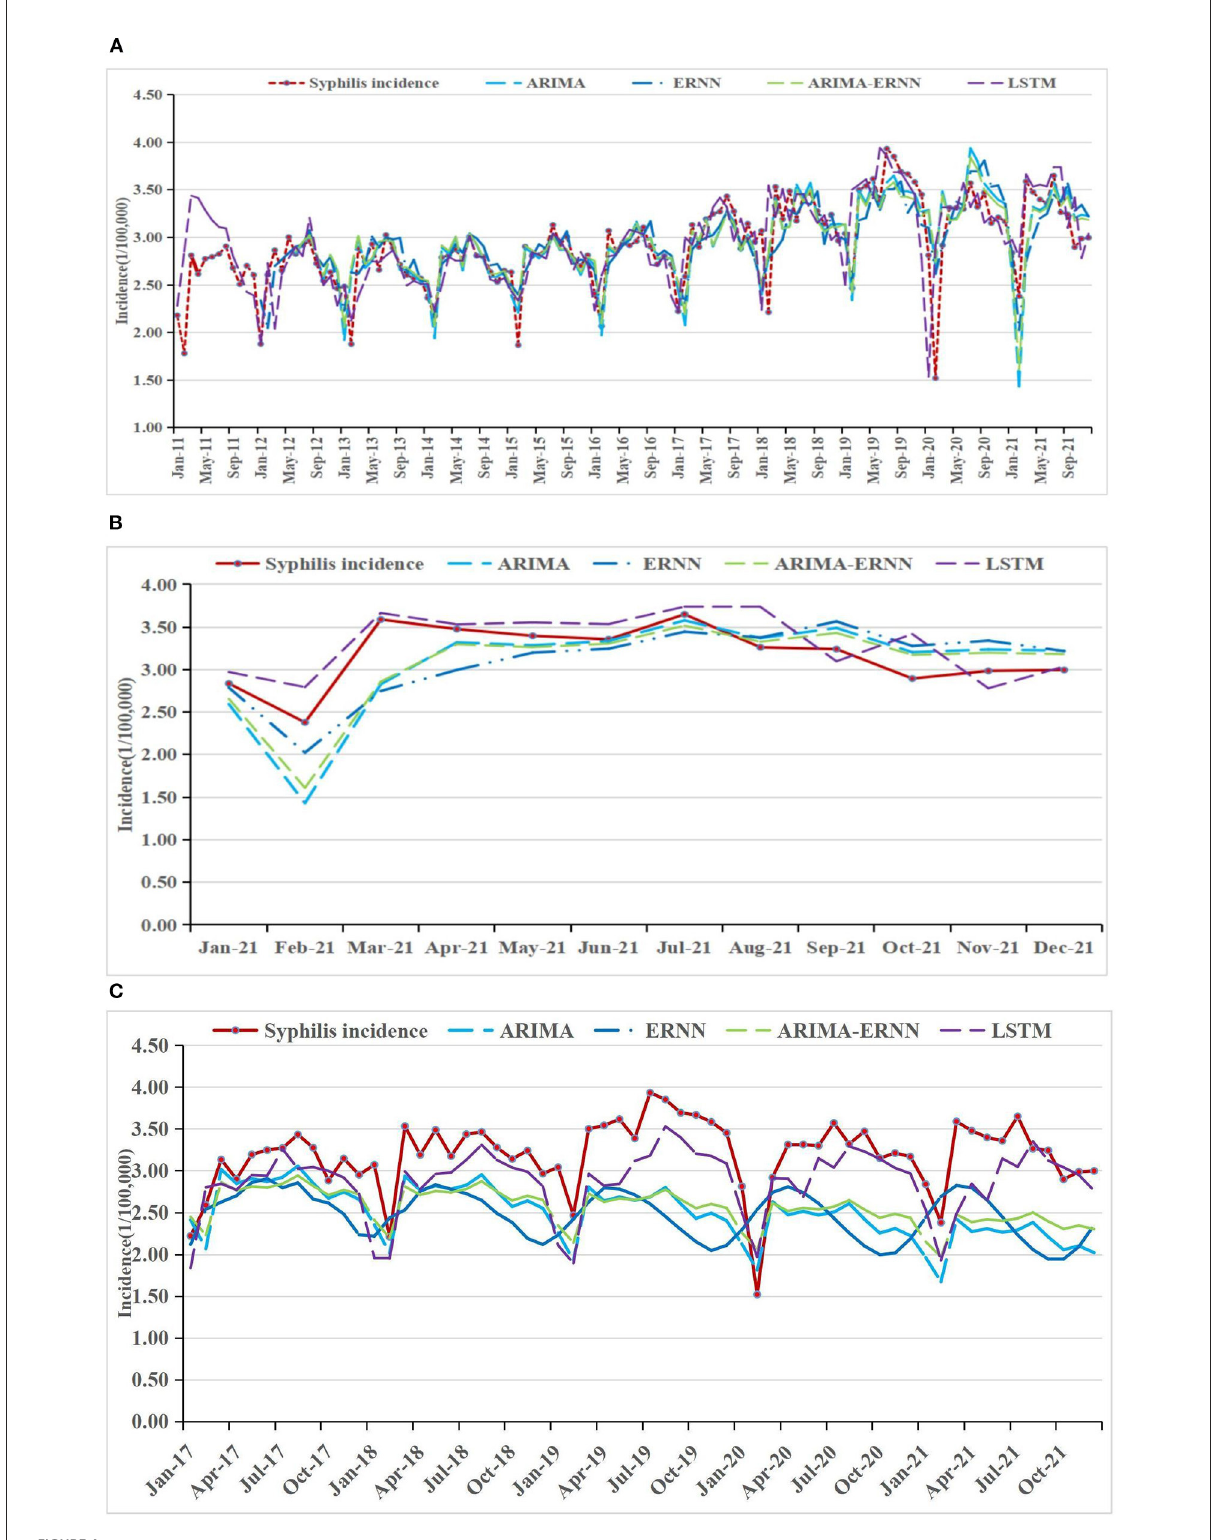
FIGURE4 Syphilis incidence and fitting values predicted by the four methods (A) in 2011–2021, (B) in 2021, and (C) in